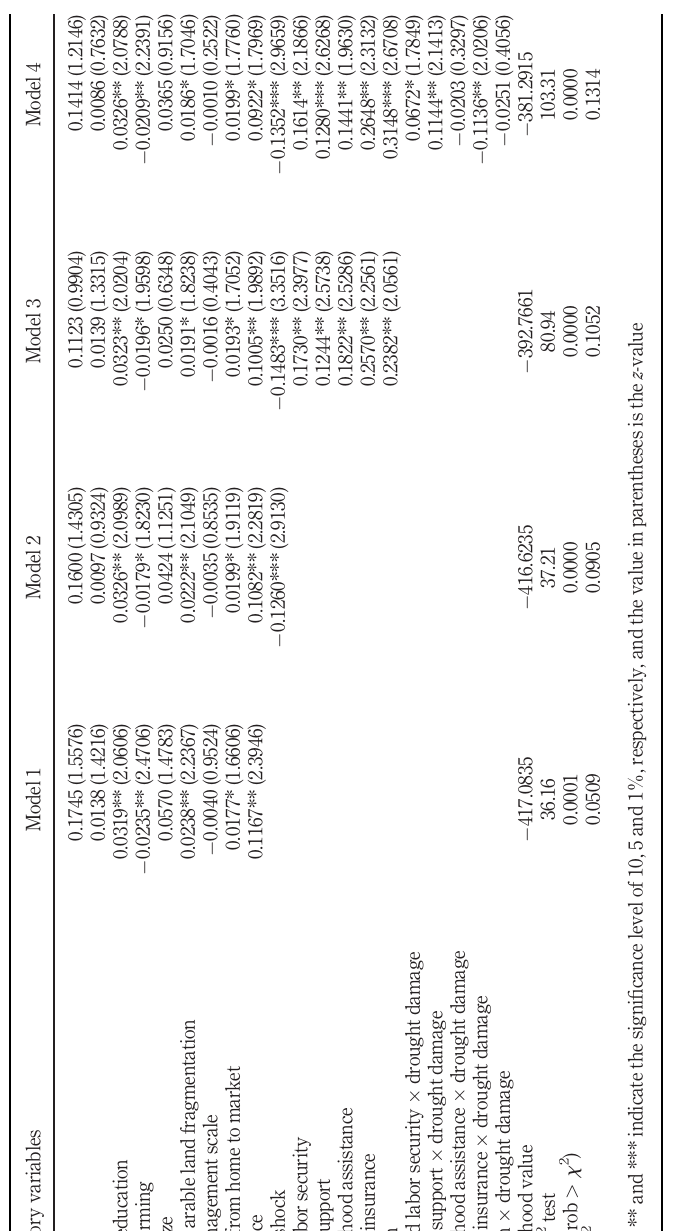
Table 4. Regression results of probit